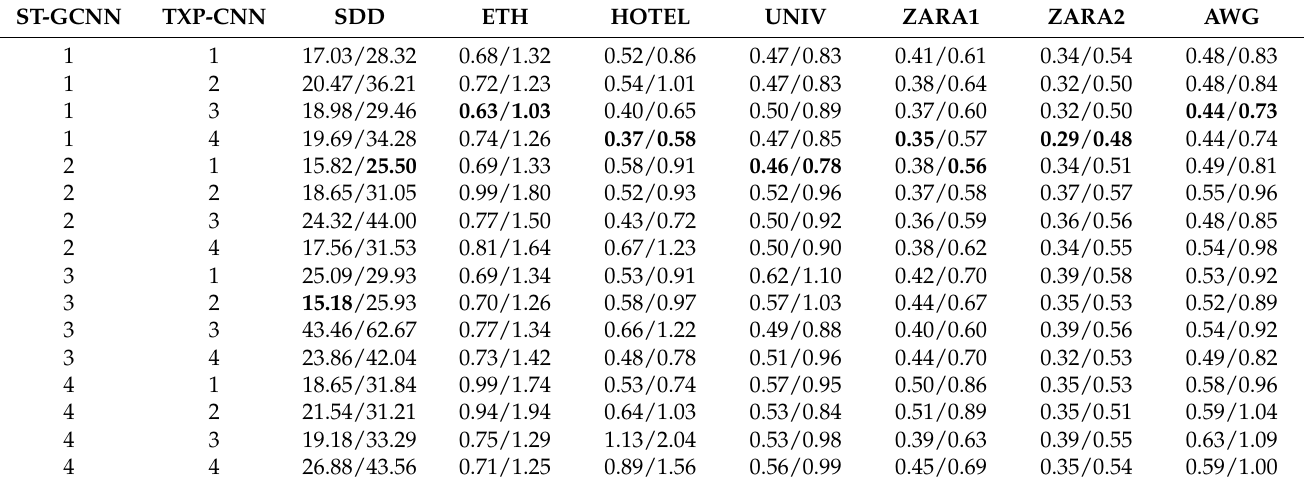
Table 1. Results of different parameter combinations applied on the ETH, UCY, and SDD datasets. The results are shown in terms of the average ADE/FDE metrics. The AWG column represents the average ADE/FDE results for all scenes of the ETH-UCY datasets. The best results are indicated in bold. Lower numerical results are